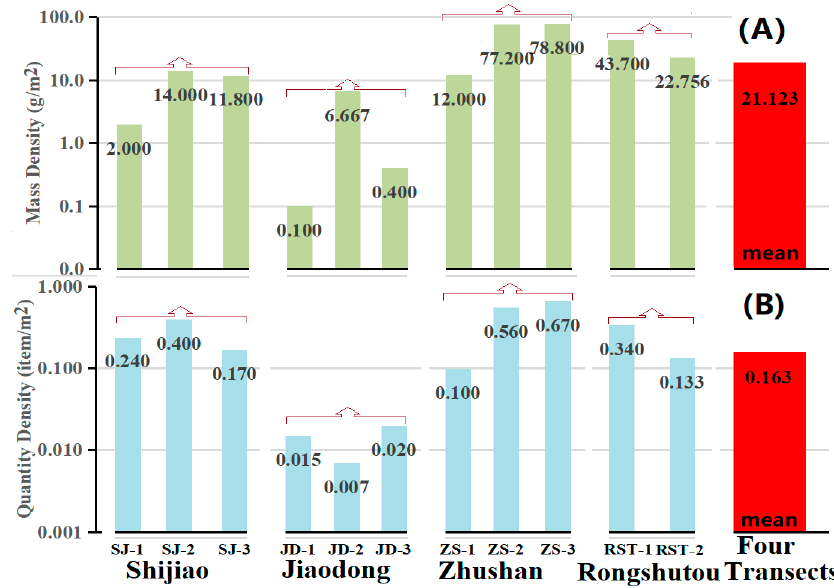
Figure 3. The mass ( A ) and quantity ( B ) densities of the debris.